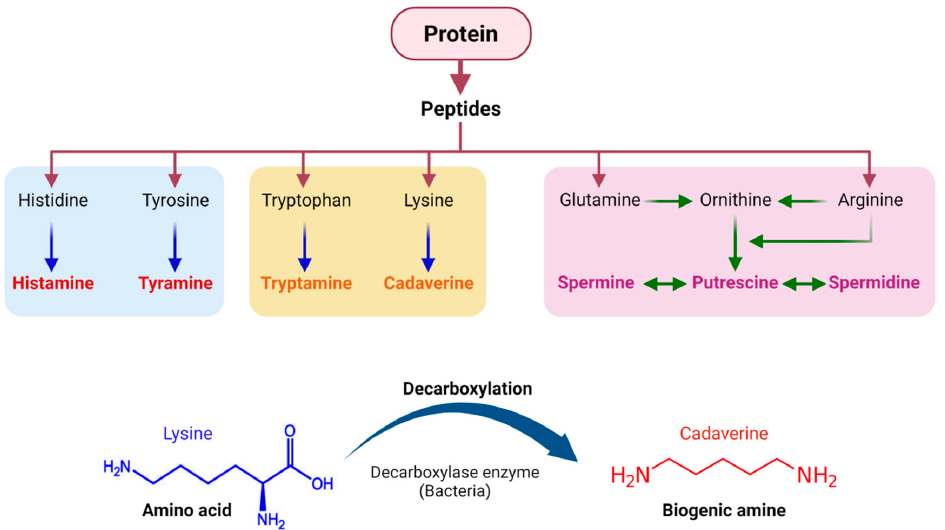
Figure 1. Biogenic amine (BA) formation and the action of decarboxylase from bacteria.